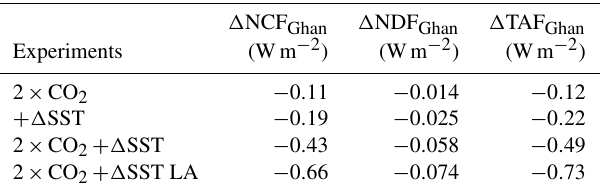
Table 2. Difference in the global annual average NCF Ghan , NDF Ghan and total aerosol forcing (TAF Ghan ) between the FB-ON and FB-OFF